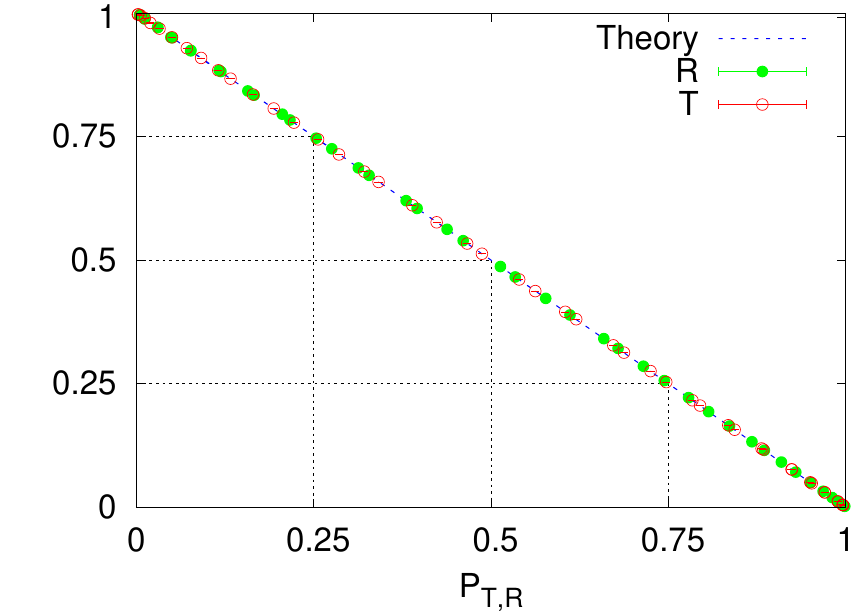
Figure 3. Fano factor as function of the transmitted and reflected probabilities P T (red circles) and P R (green circles). The time series of photons obtained in the transmitted and reflected detectors displays quantum chaos at F = 0.25 (0.75) for P = 0.75